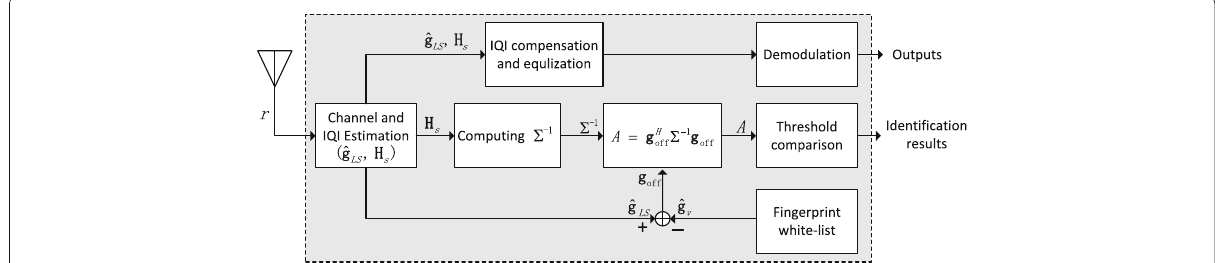
Fig. 2 Block diagram of the whitelist-based identification procedure at